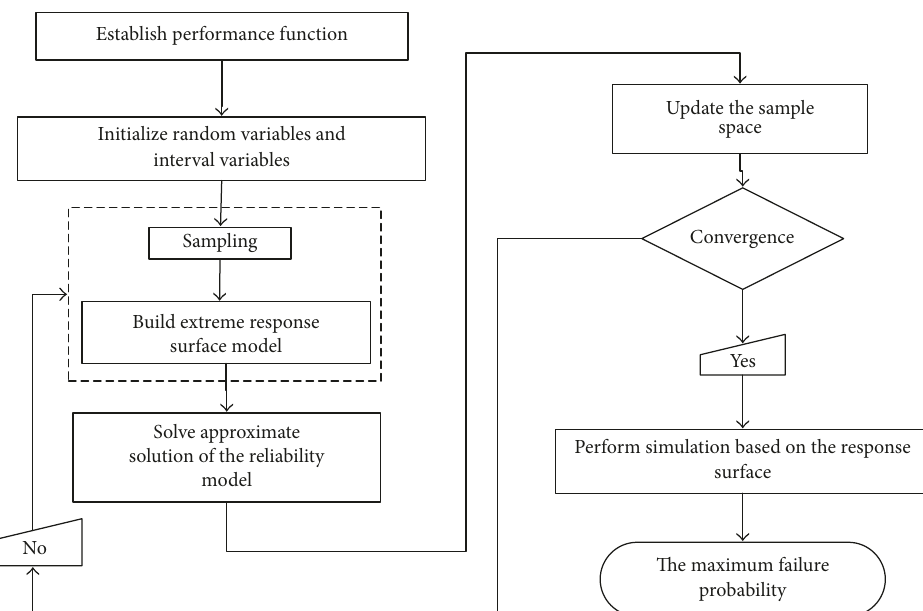
Figure 5: Flow chart of hybrid reliability analysis based on the extreme response